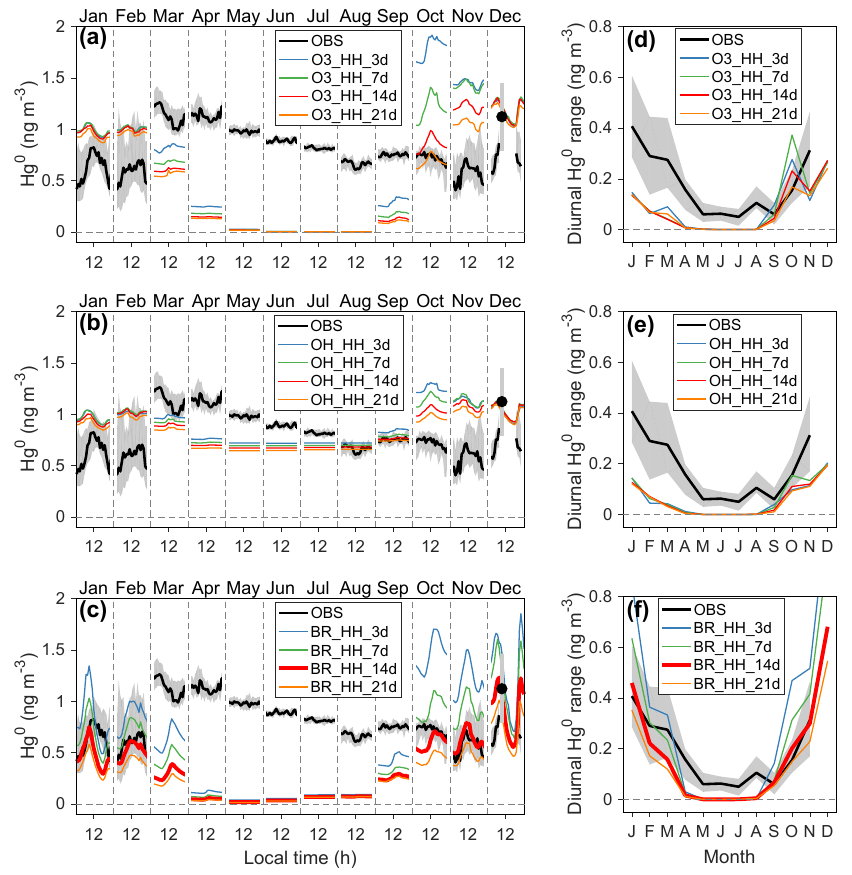
Figure 3. Comparison of seasonal and diurnal variations of near-surface atmospheric Hg 0 concentrations between observations and model. Panels (a) – (c) show monthly and diurnal Hg 0 observations in the year 2013 and modeling results from different scenarios. Panels (d) – (f) show diurnal Hg 0 ranges calculated from the maximum and minimum hourly concentrations in each month. The shaded regions indicate 25% and 75% percentiles in observations. Observations were conducted at 25cm above the snow surface at Dome C. The name of each scenario reflects the atmospheric oxidant, its concentration levels, chemical reaction rates (H indicates “high” or “upper”; L indicates “low” or “lower”), and the photoreduction rates of snow mercury (in days). For example, the scenario with name “O3_HH_3d” assumes O 3 as the oxidant, and high oxidant concentrations and high reaction rates are applied, and τ PR is set to 3 days.